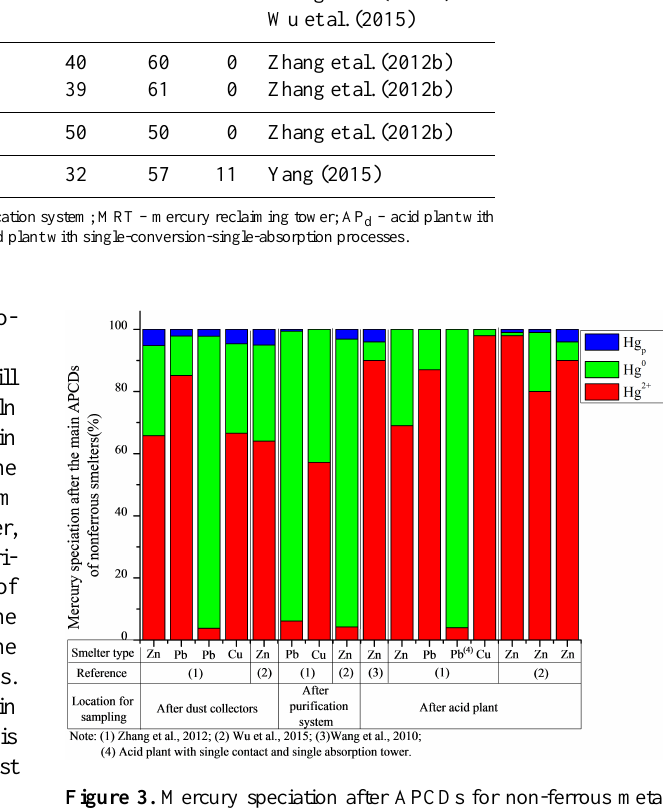
Figure 3. Mercury speciation after APCDs for non-ferrous metal